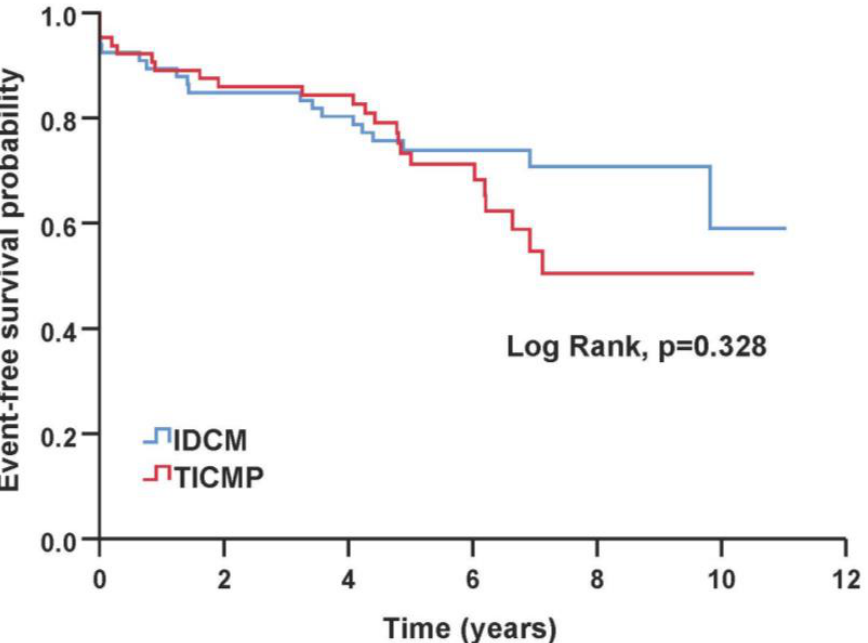
Figure 2. Kaplan – Meier curve of time to primary composite endpoint. IDCM — idiopathic dilated cardiomyopathy; TICMP — tachycardia-induced cardiomyopathy.